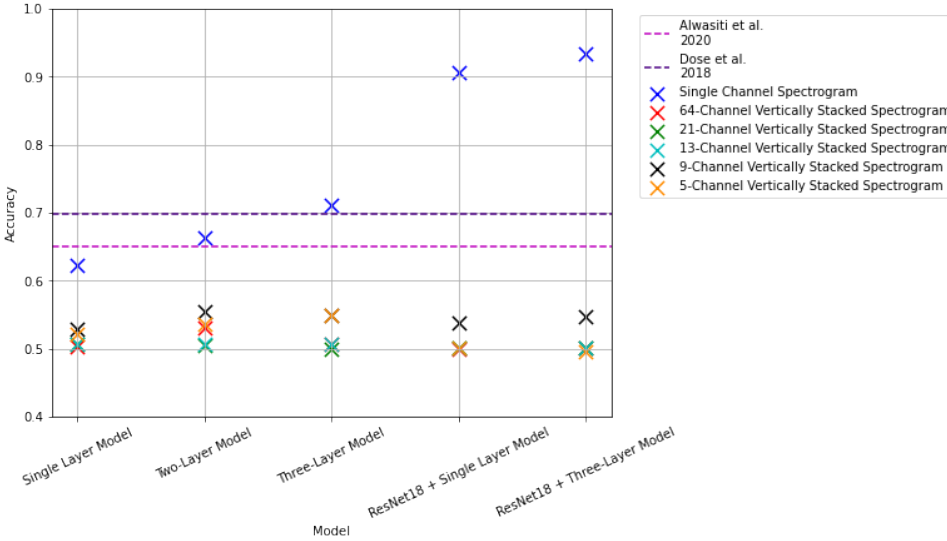
Figure 20. Results of image-based experiments of single-channel spectrogram images and vertically stacked spectrogram images with the 2D CNN models. The pink dashed line indicates results reported in [25]. The purple dashed line indicates results reported in